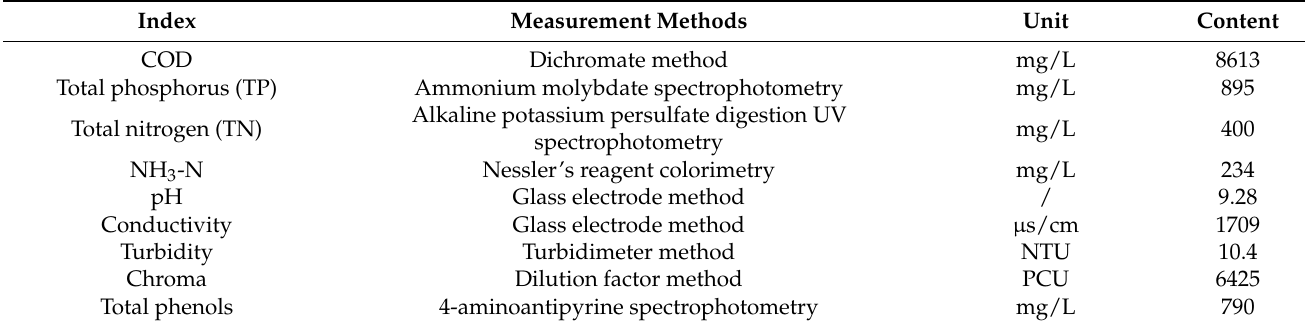
Table 1. Water quality indicators and measurement